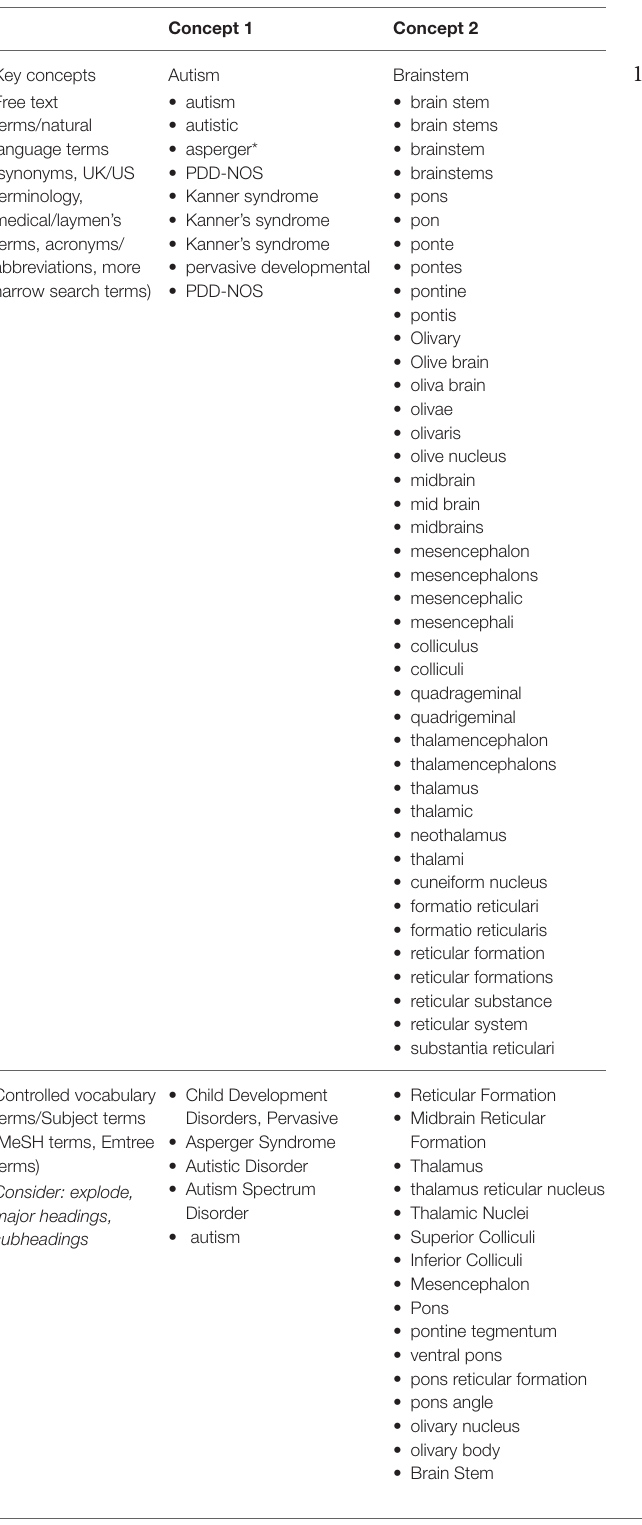
TABLE 1 | Search strategy used to search on all databases.